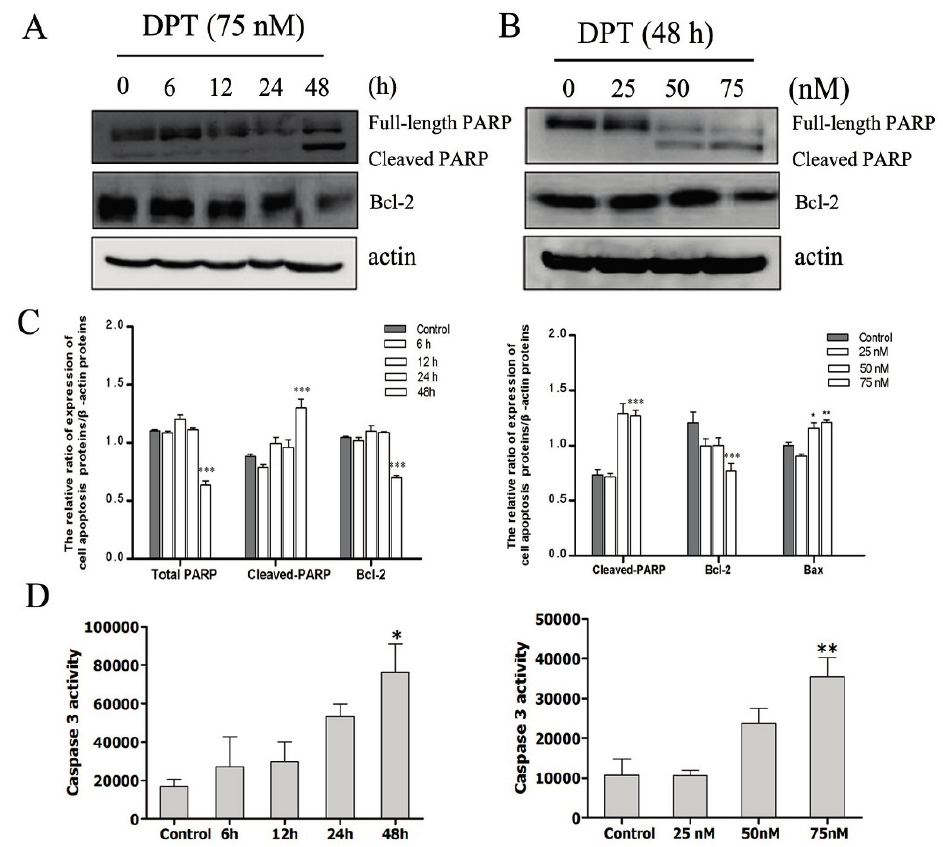
Figure 6. Effects of DPT on apoptotic-related protein and caspase-3 activity in SGC-7901 cells. The levels of PARP and Bcl-2 were assessed by western blot analysis. Capase-3 activity was evaluated by the detection of the cleavage of a colorimetric caspase-3 substrate, N-acetyl-Asp-Glu-Val-Asp (DEVD)-p-nitroaniline. ( A ) Cells were treated with 75 nM of DPT for the indicated time periods. ( B ) Cells were treated with different concentrations of DPT for 48 h. ( C ) Statistical analysis of PARP and Bcl-2. ( D ) Statistical analysis